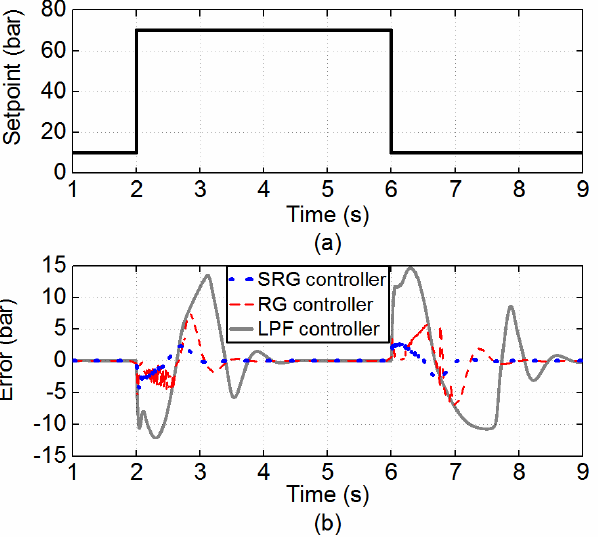
Figure 7. Tracking performance for a step trajectory from 10 bar to 70 bar. ( a ) The pressure trajectory. ( b ) The tracking error of the three controllers.